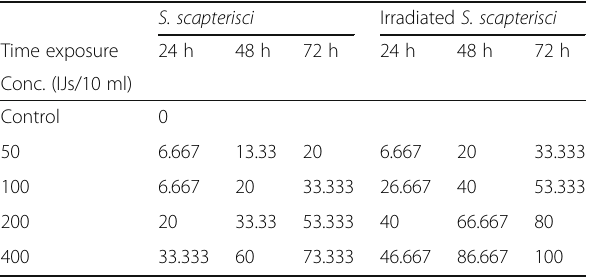
Table 2 Accumulative percentage mortality of the fourth instar